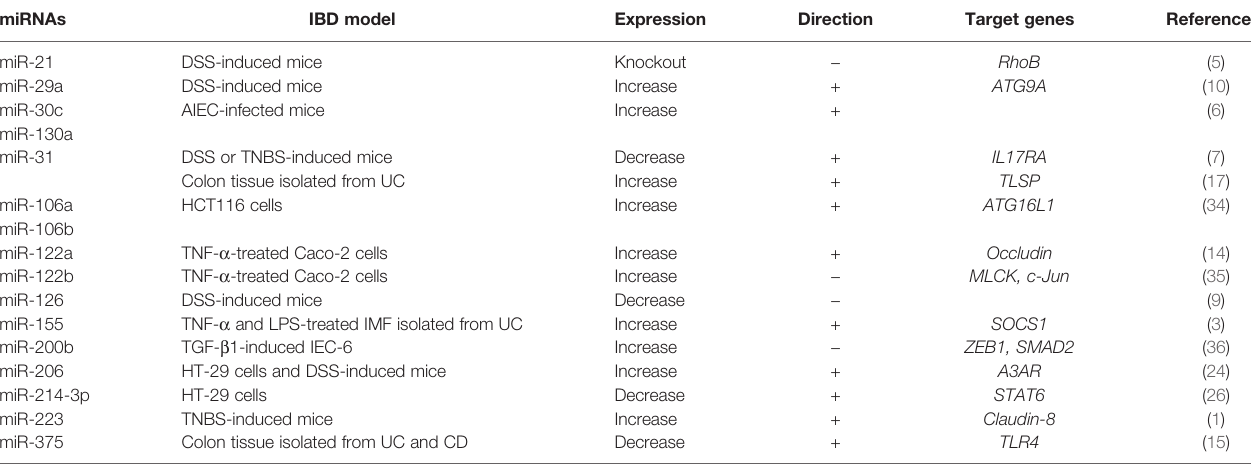
TABLE 2 | Summary of speci fi c miRNAs and its target gene involved in IBD model.